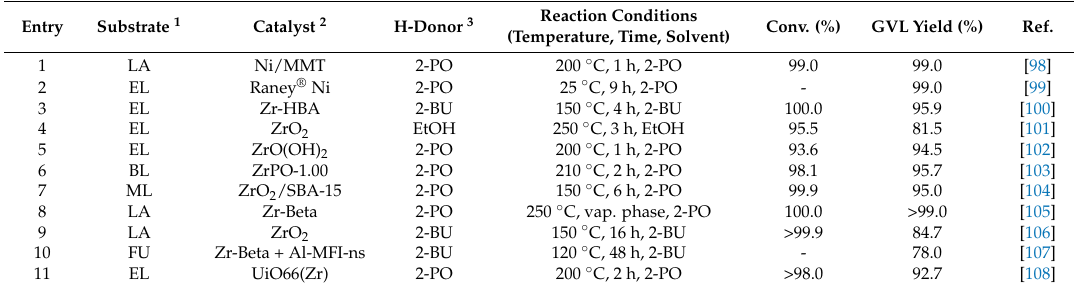
Table 5. Representative heterogeneous catalysts in the CTH of LA and its derivatives using different alcohols as hydrogen